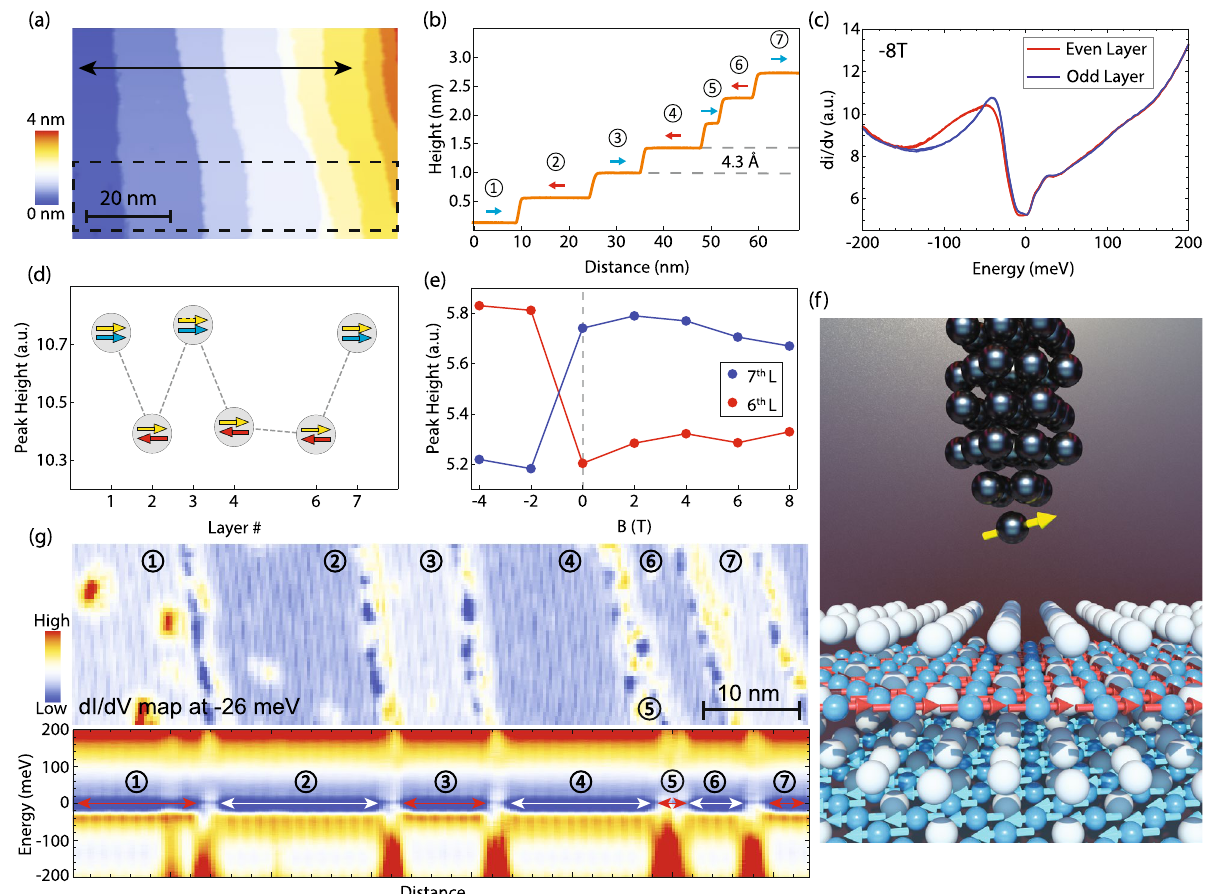
Figure 3. Spin-polarized imaging the layered antiferromagnetic structure of the Sn layer. ( a ) STM topograph of a region containing 7 unit cell step heights using a spin-polarized STM tip. ( b ) A topographic line profile along the black line in ( a ). The red and blue arrows in ( b ) denote the spins in each step. ( c ) Average dI/dV spectra taken over even (red curves) and odd (blue curves) steps in ( a ) under − 8 T magnetic field applied perpendicular to the surface. Note that the 1st, the 3rd, and the 7th layer have exactly the same spectra (the blue one); the 2nd, the 4th, and the 6th layers also share the same spectrum (red one). ( d ) The spectral peak height at ~ − 50 meV as a function of the layer number marked in ( b ). Yellow arrow stands for tip spin polarization, while the blue and red arrows stand for odd layer and even layer spin polarizations, respectively. ( e ) Spectral peak height plotted as a function of applied magnetic field magnitude for the 6th layer (red) and the 7th layer (blue). ( f ) A 3D model to show the spatial relation between the spin-polarized tip and the sample spins. ( g ) The upper panel is a dI/dV map across the 7 steps at − 26 mV bias setting (same region as the dashed rectangle in panel ( a )); the lower panel is a dI/dV spectrum linecut taken across the same region. STM setup condition: ( a ) I set = 10 pA, V sample = 400 mV; ( c , e , g ) I set = 800 pA, V sample = 200 mV, V exc = 2